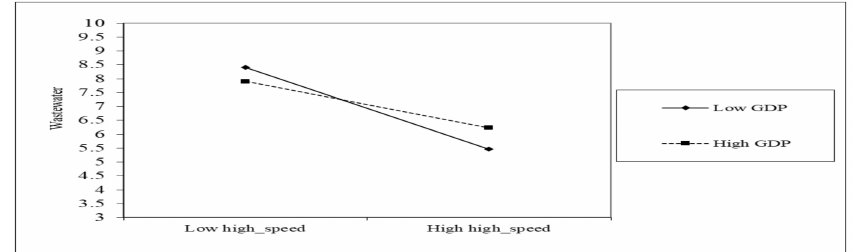
Figure 4. The moderating effect of